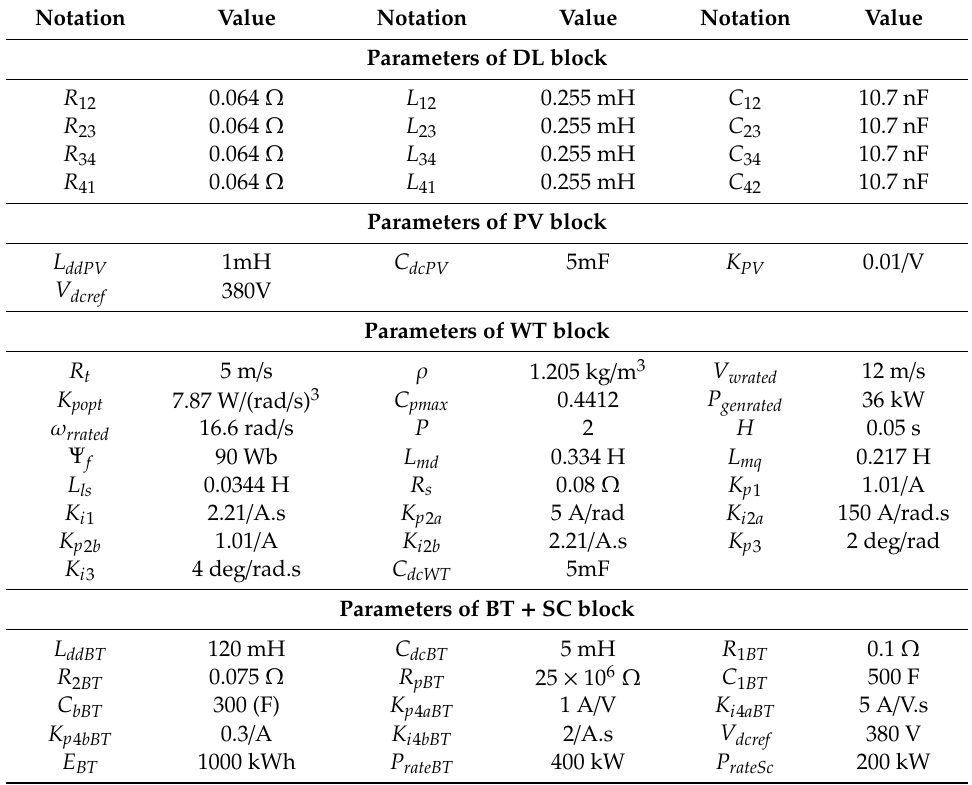
Table A1. Parameters of the DC microgrid (as shown in Figure